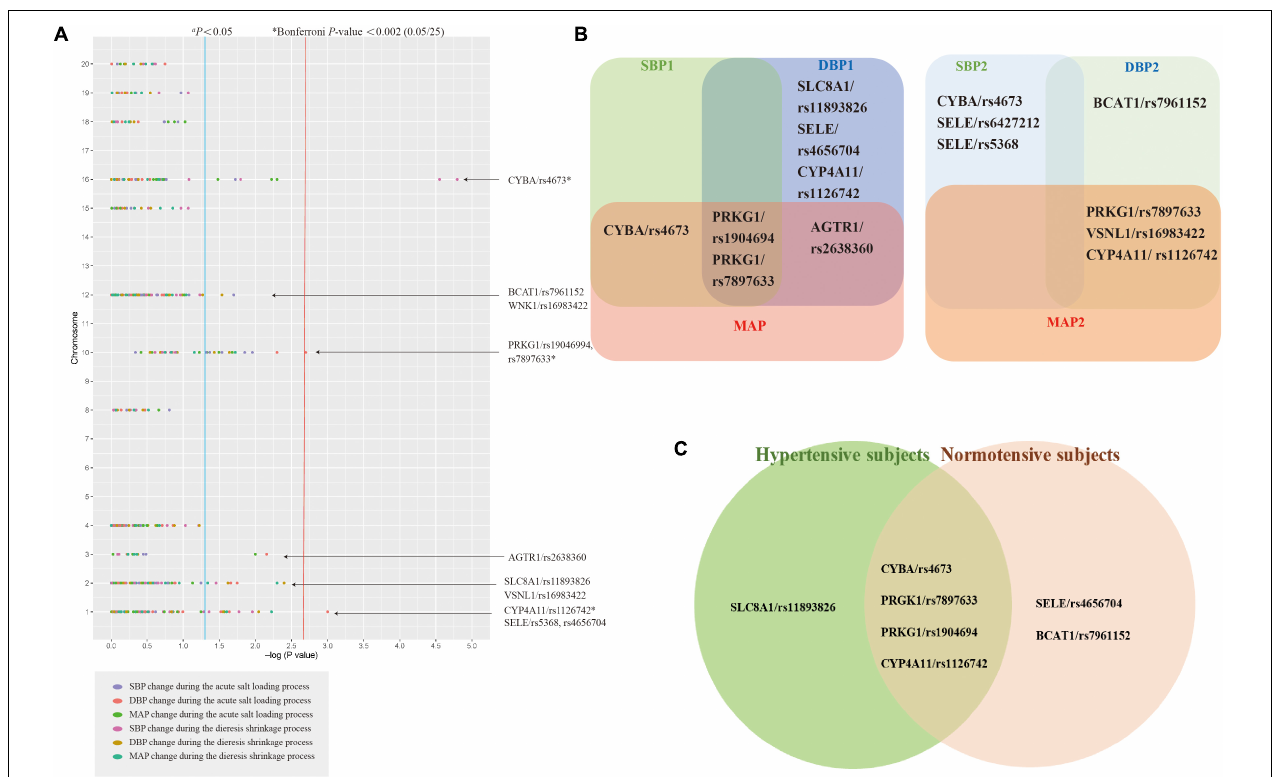
FIGURE 1 | The association between the single-nucleotide polymorphisms (SNPs) and SSBP. Analysis of association between 25 SNPs in 23 genes and six phenotypes for salt sensitivity of blood pressure (SSBP) in 2,057 participants a (A) . The Venn diagrams comparing the identified SNPs between each SBP, DBP, MAP during acute salt loading and diuresis shrinkage in all subjects (B) . The Venn diagrams comparing the identified SNPs between the hypertensive subjects and normotensive subjects (C) . Each SNP-SSBP trait association is represented by a dot and is color coded according to the SSBP trait. a The genes indicated down the right side of the figure are those having at least one SNP associated with one of the SSBP phenotypes with P < 0.05. *Bonferroni correction P -value <